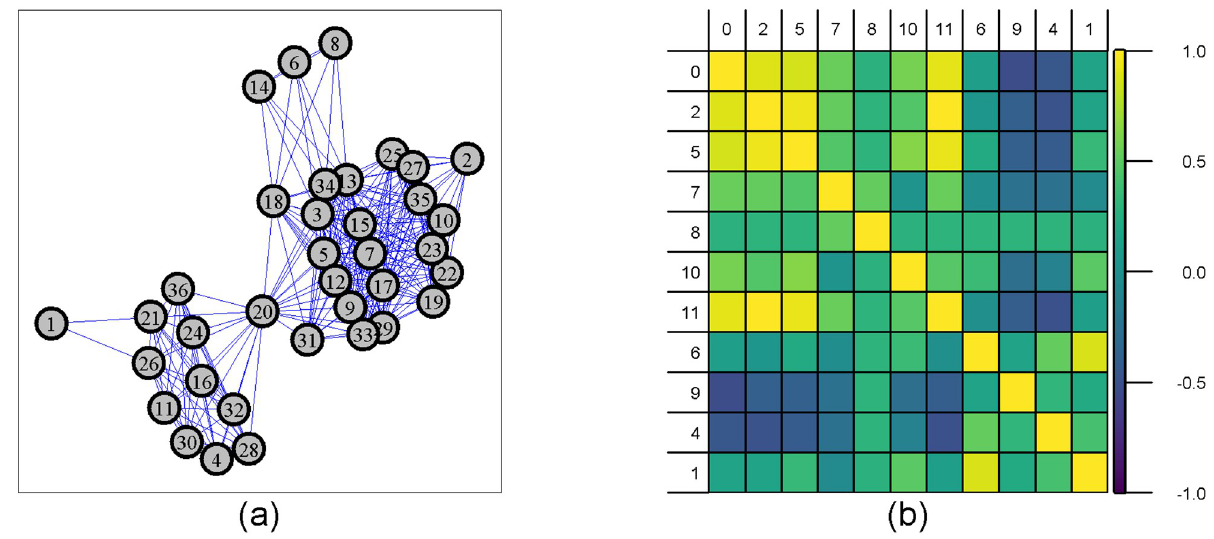
Fig 5. Illustration of an empirical graph and its Graphlet Correlation Matrix. (a) Example of an empirical graph (Graph 08) and (b) its Graphlet Correlation Matrix ( GCM ). The 11 non-redundant orbits are grouped according to their role , orbit {0} represents the familiar degree, {2, 5, 7} represent node in chain, {8, 10, 11} represent node in cycle, and {6, 9, 4, 1} represent terminal node. Cell colours correspond to the value of the correlation coefficient between the 11 non-redundant orbits from 1 (yellow) to − 1 (dark purple).